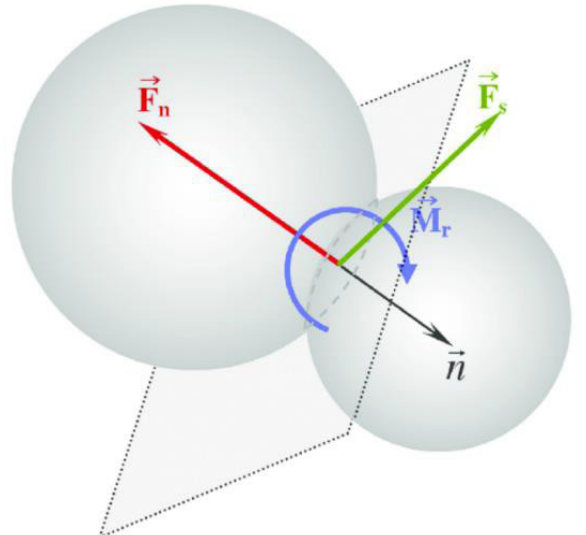
Figure 1: Two spheres in contact with forces and momentum acting on them ( F